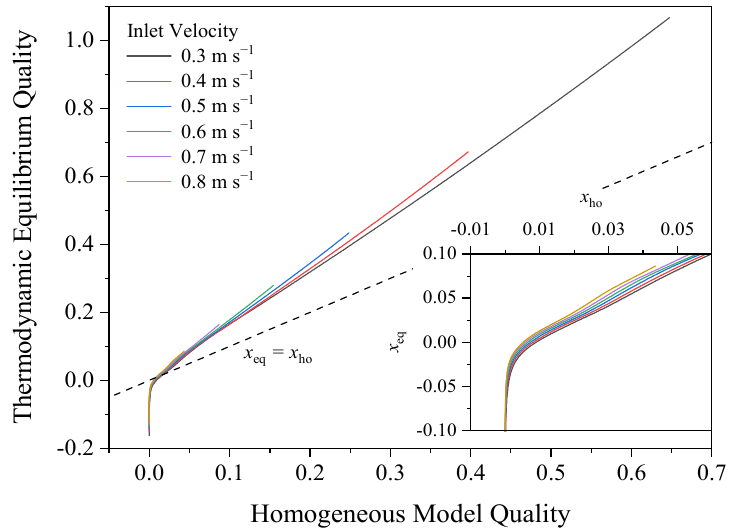
Figure 23. Homogenous model quality vs. thermodynamic equilibrium quality at inlet velocities of 0.3 m · s − 1 to 0.8 m · s − 1 .